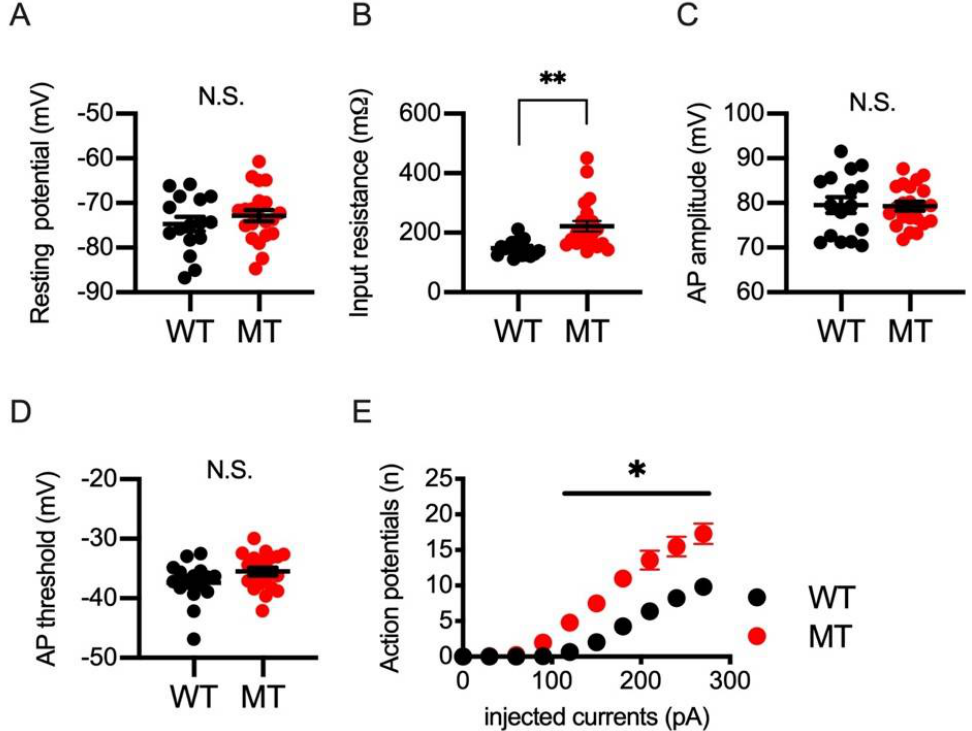
Figure 3. Electrophysiological parameters of neurons in the somatosensory cortex of wild-type and SIK1-MT mice. ( A ) Resting potential was unchanged between wild-type and SIK1-MT mice. ( B ) Input resistance of neurons was increased in SIK1-MT more than in wild-type mice. ( C ) The amplitude or ( D ) the threshold of the action potential of neurons was not changed between both genotypes.